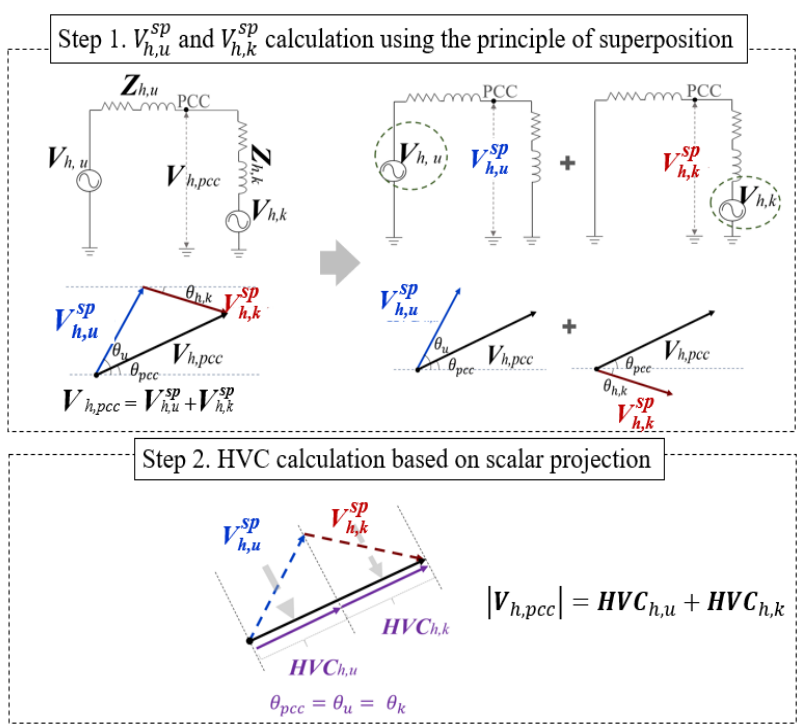
Figure 6. The harmonic contribution to the PCC voltage based on the principle of superposition and scalar projection.